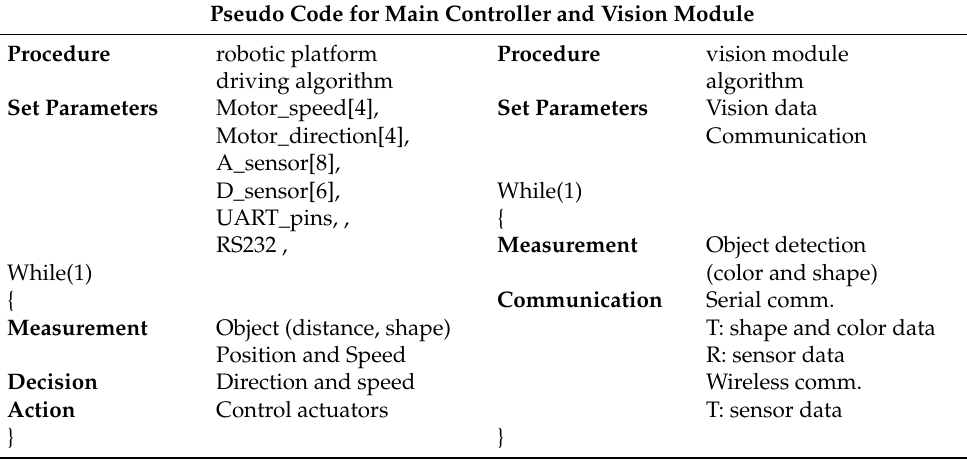
Table 1. Pseudo code for the main controller and vision module in the communication processing of the vision module. T: transmit; R: